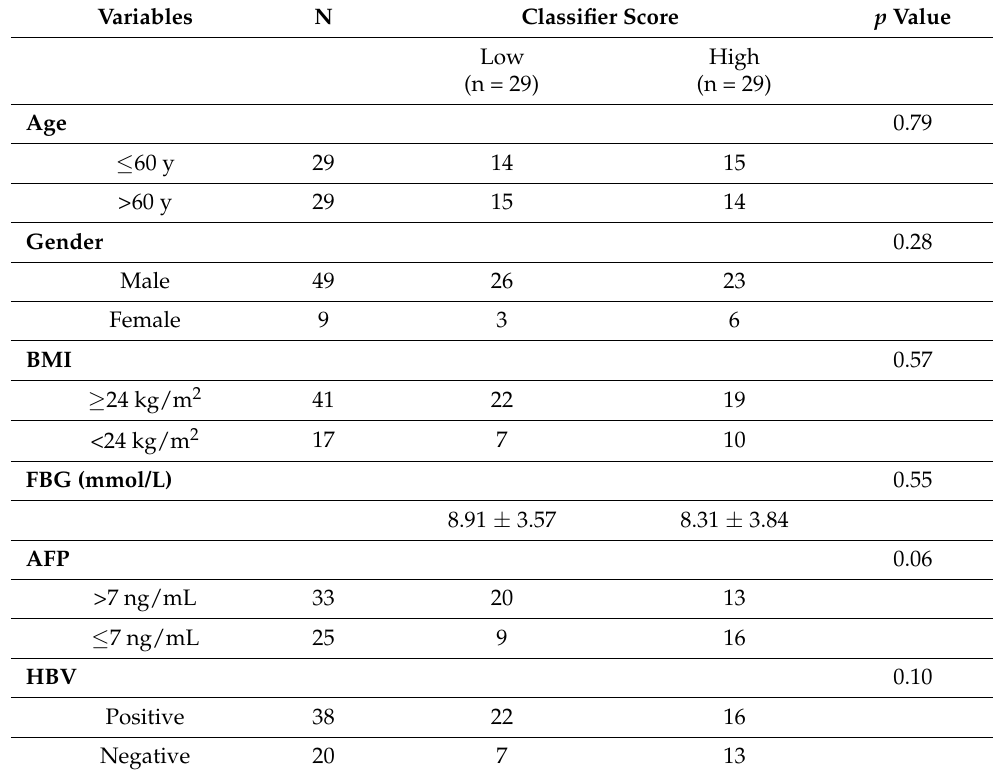
Table 5. Correlation of the classifier score with clinical characteristics in T2DM(+) HCC patients in the validation